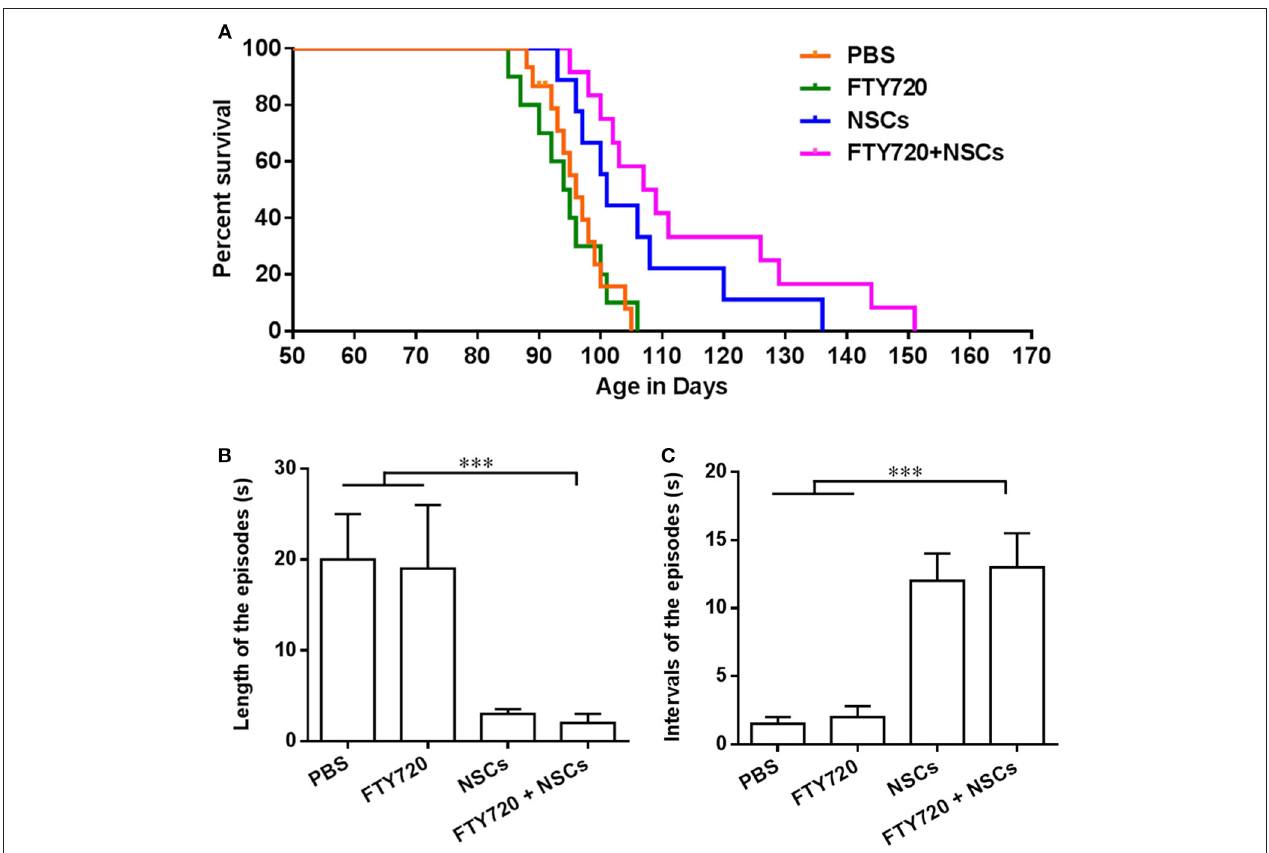
FIGURE 5 | FTY720 in combination with transplanted NSCs improved neurological function and diminished seizures of shiverer mice. (A) Transplanted NSCs and FTY720-NSC co-treatment prolong the survival of shiverer mice. Newborn double-homozygous shiverer ( shi/shi ) mice were implanted i.c.v. with dissociated single NSCs (2.0 × 10 5 cells/mouse), and injected i.p. with fingolimod (at 0.3 mg/kg daily) ( n = 12) from the day of cell injection. Shiverer mice that received NSCs ( n = 14), or fingolimod ( n = 12) alone served as single-treatment controls, and mice that received the same volume of phosphate-buffered saline (PBS) served as a sham-treated control ( n = 12). All these shiverer mice were maintained in small group housing and monitored daily until death. The Kaplan-Meier survival graph, plotting the percentage of each group alive in days, is shown. (B) Quantification of length of episodes. (C) Quantification of intervals of episodes. Symbols represent mean ± SD. *** p < 0.01. One-way ANOVA with Tukey’s multiple comparisons test and unpaired Student’s t